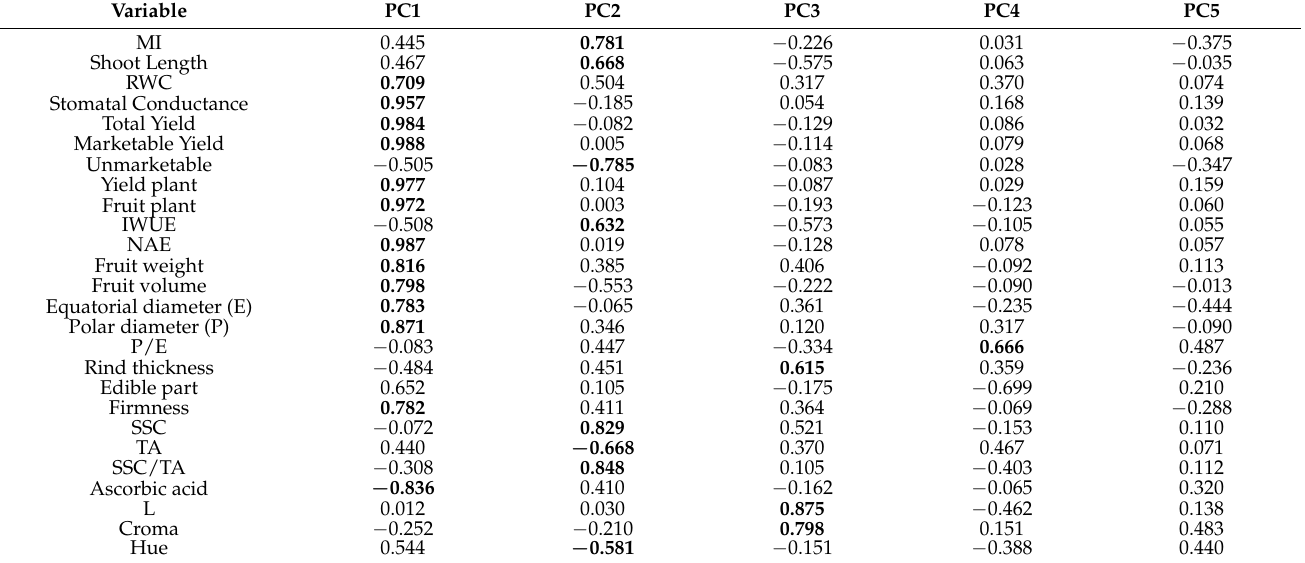
Table 5. Correlation of variables to the factors of the principal components analysis (PCA) based on the agronomic and yield quality characteristics of